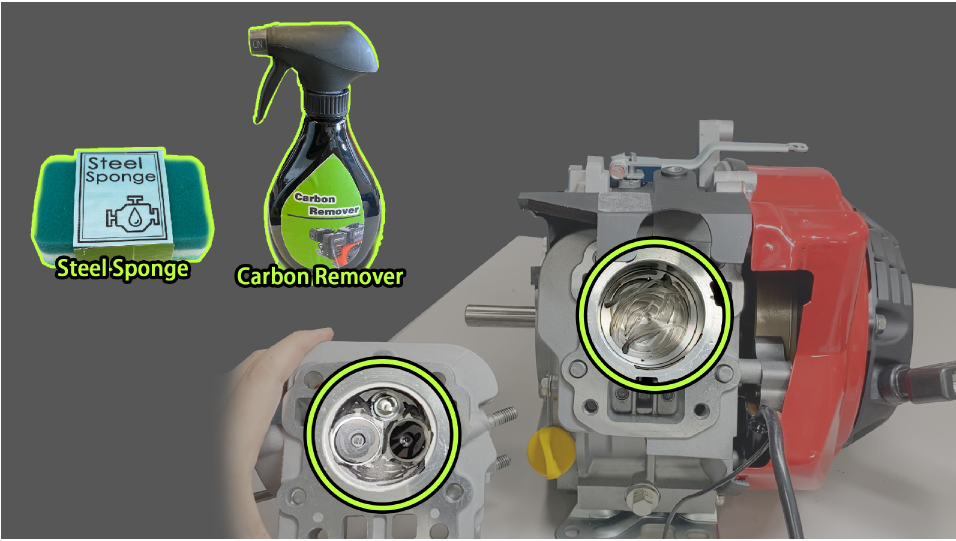
Figure 26. Task 1: Engine carbon cleaning task.